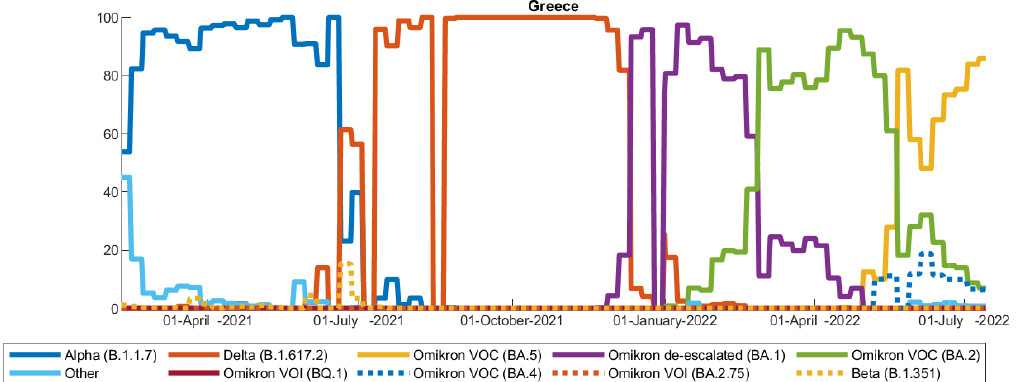
Figure 1. Proportion of SARS ‐ CoV ‐ 2 variants in Greece for the time period 1 February 2021–15 June 2022. Data are provided by h tt ps://www.ecdc.europa.eu/ (accessed on 14 February 2023).